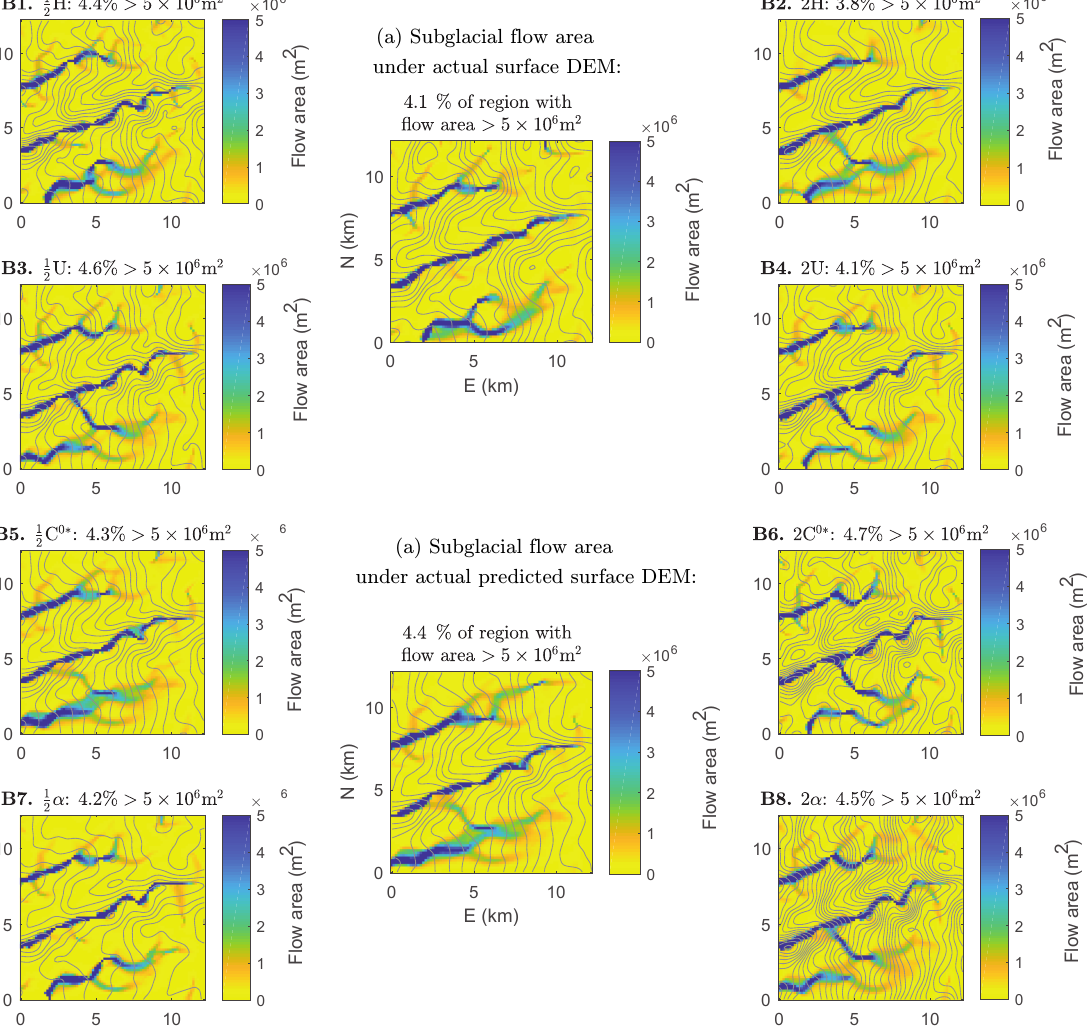
Figure 12. (a) Subglacial accumulated flow (drainage) area obtained via flow routing on hydraulic potential fields calculated under the actual ice surface DEM from BedMachine/GIMP (Howat et al., 2014; Morlighem et al., 2017a). Grey contours in all plots are 0.1MPa hydraulic potential contours. (b, B1–B8) Subglacial accumulated flow area calculated under the ice surface predicted with bed topography transfer with various ice flow parameters. Study region R1 (Fig. 1a, Table 1) with η = 10 14 Pas and baseline C 0 ∗ = 10. The flow area threshold displayed (5 × 10 6 m 2 ) was chosen to highlight pathways of high relative water